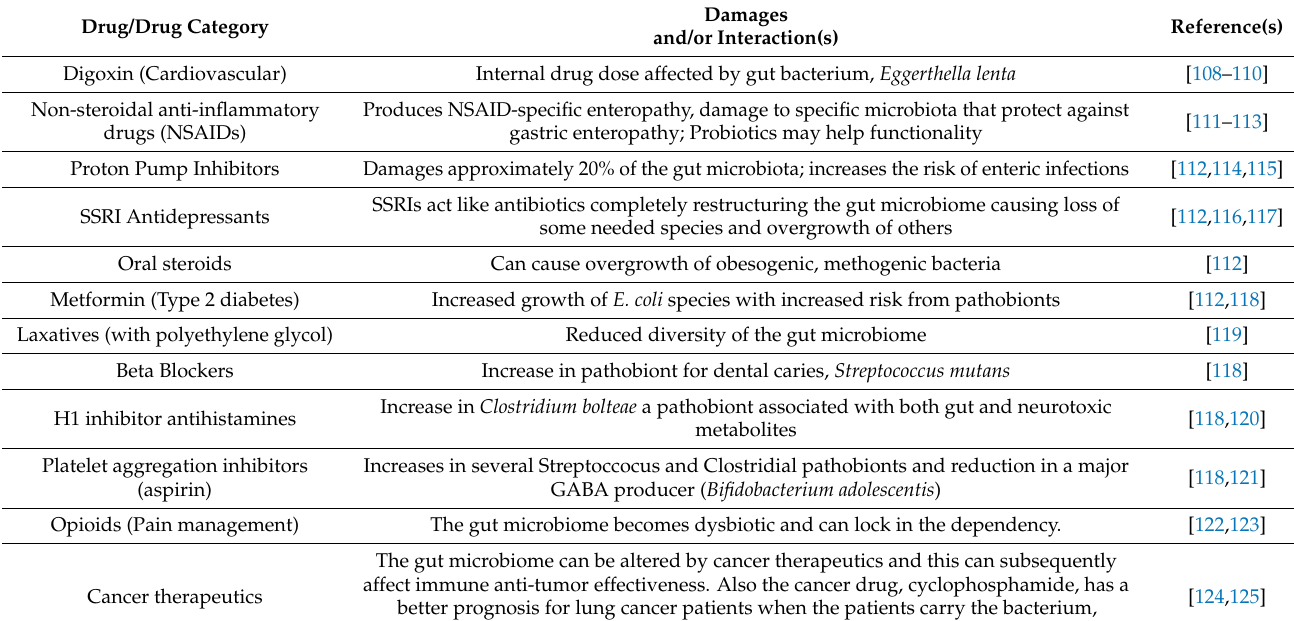
Table 3. Examples of Drug Interactions with the